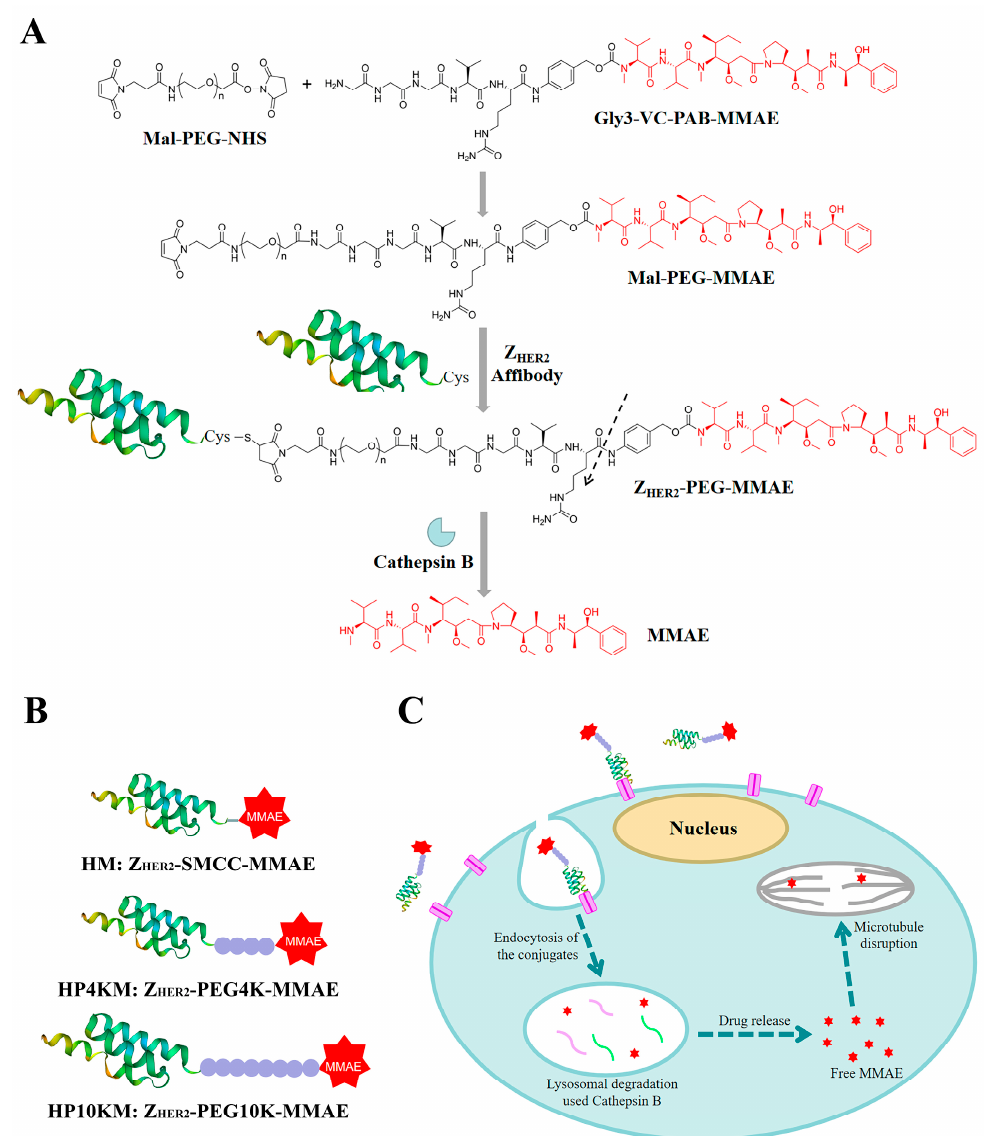
Figure 1. Strategy of comodification of affibody Z HER2:2891 with PEG chains and MMAE. ( A ) Structure of Gly3-VC-PAB- MMAE, synthetic strategy for generation of the different conjugates and cathepsin B drug release. ( B ) Schematic illustration of HM, HP4KM, and HP10KM. ( C ) General mechanism of the action of the conjugates. The conjugates bind to their target receptor (HER2 protein) on the cell surface to form an ADC-antigen complex, leading to endocytosis of the complex. The internalized conjugates undergo lysosomal processing and trigger intracellular drug release, leading to tumor cell death.